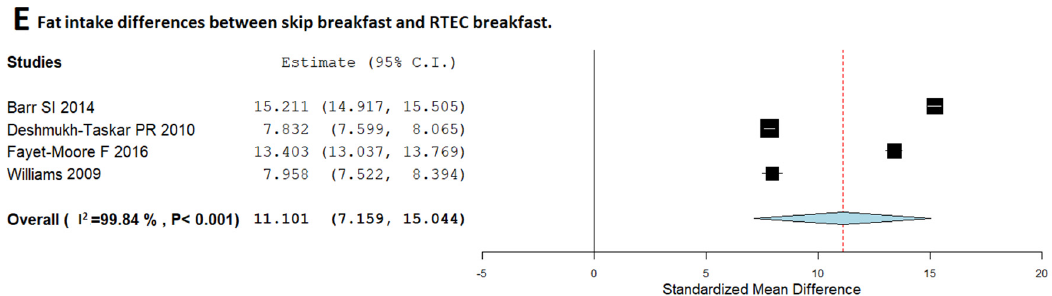
Figure 2. Random-effects meta-analysis of the effects of relationships between skipping breakfast and RTEC breakfast regarding energy ( A ), carbohydrates ( B ), fibre ( C ), protein ( D ) and fat ( E ) intake.